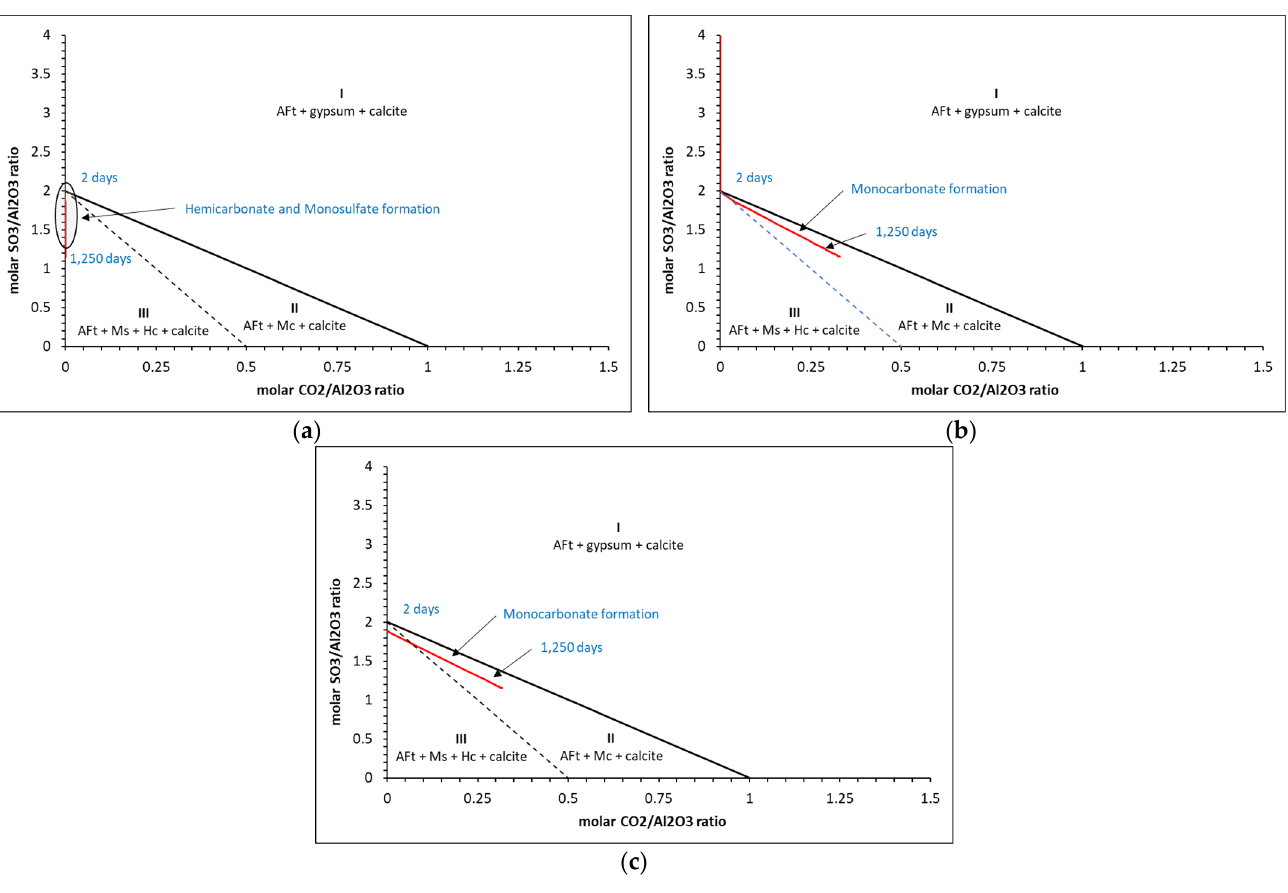
Figure 14. Thermodynamic predictions of carbonate and sulfate ratios for ( a ) 0%, ( b ) 2% and ( c ) 5% calcite for the w/c = 0.5 cement.